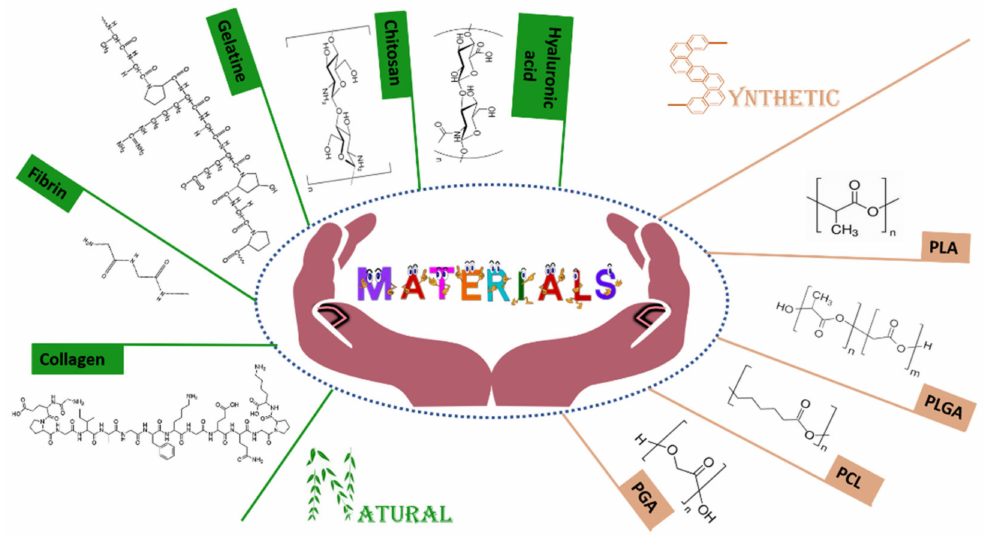
Figure 2. Natural and synthetic polymers mainly used in periodontal tissue